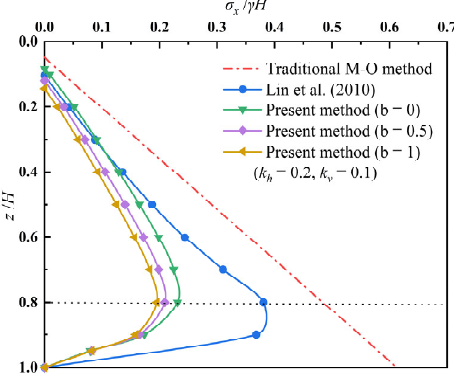
Figure 10. Comparison of active earth pressure in previous studies.